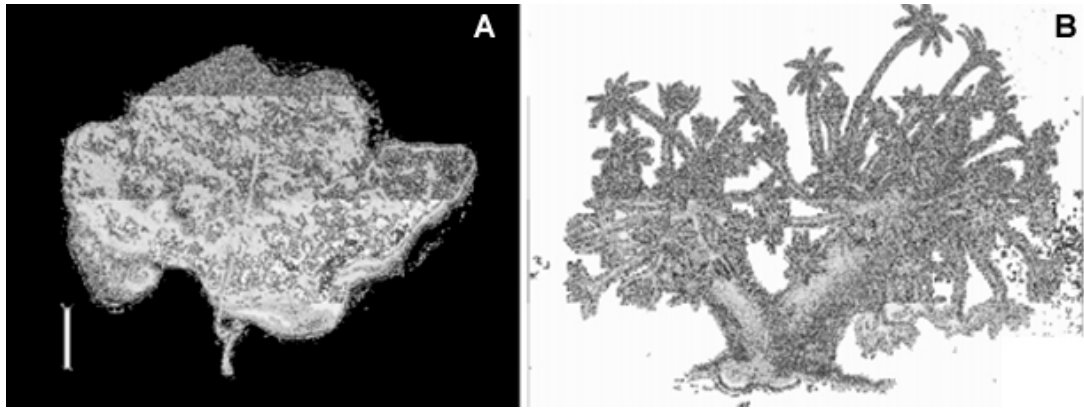
Figure 20. Specimen of Xenia elongata soft coral. ( A ) Photo of holotype in dry conditions. ( B ) Colony drawing from Dana (1846) [84].